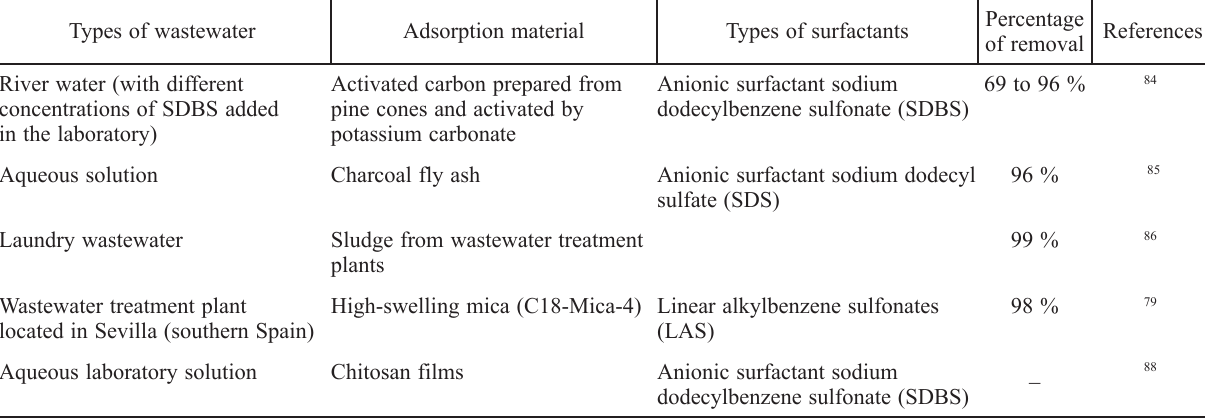
Table 5 – Removal of surfactants from wastewater by adsorption process Types of